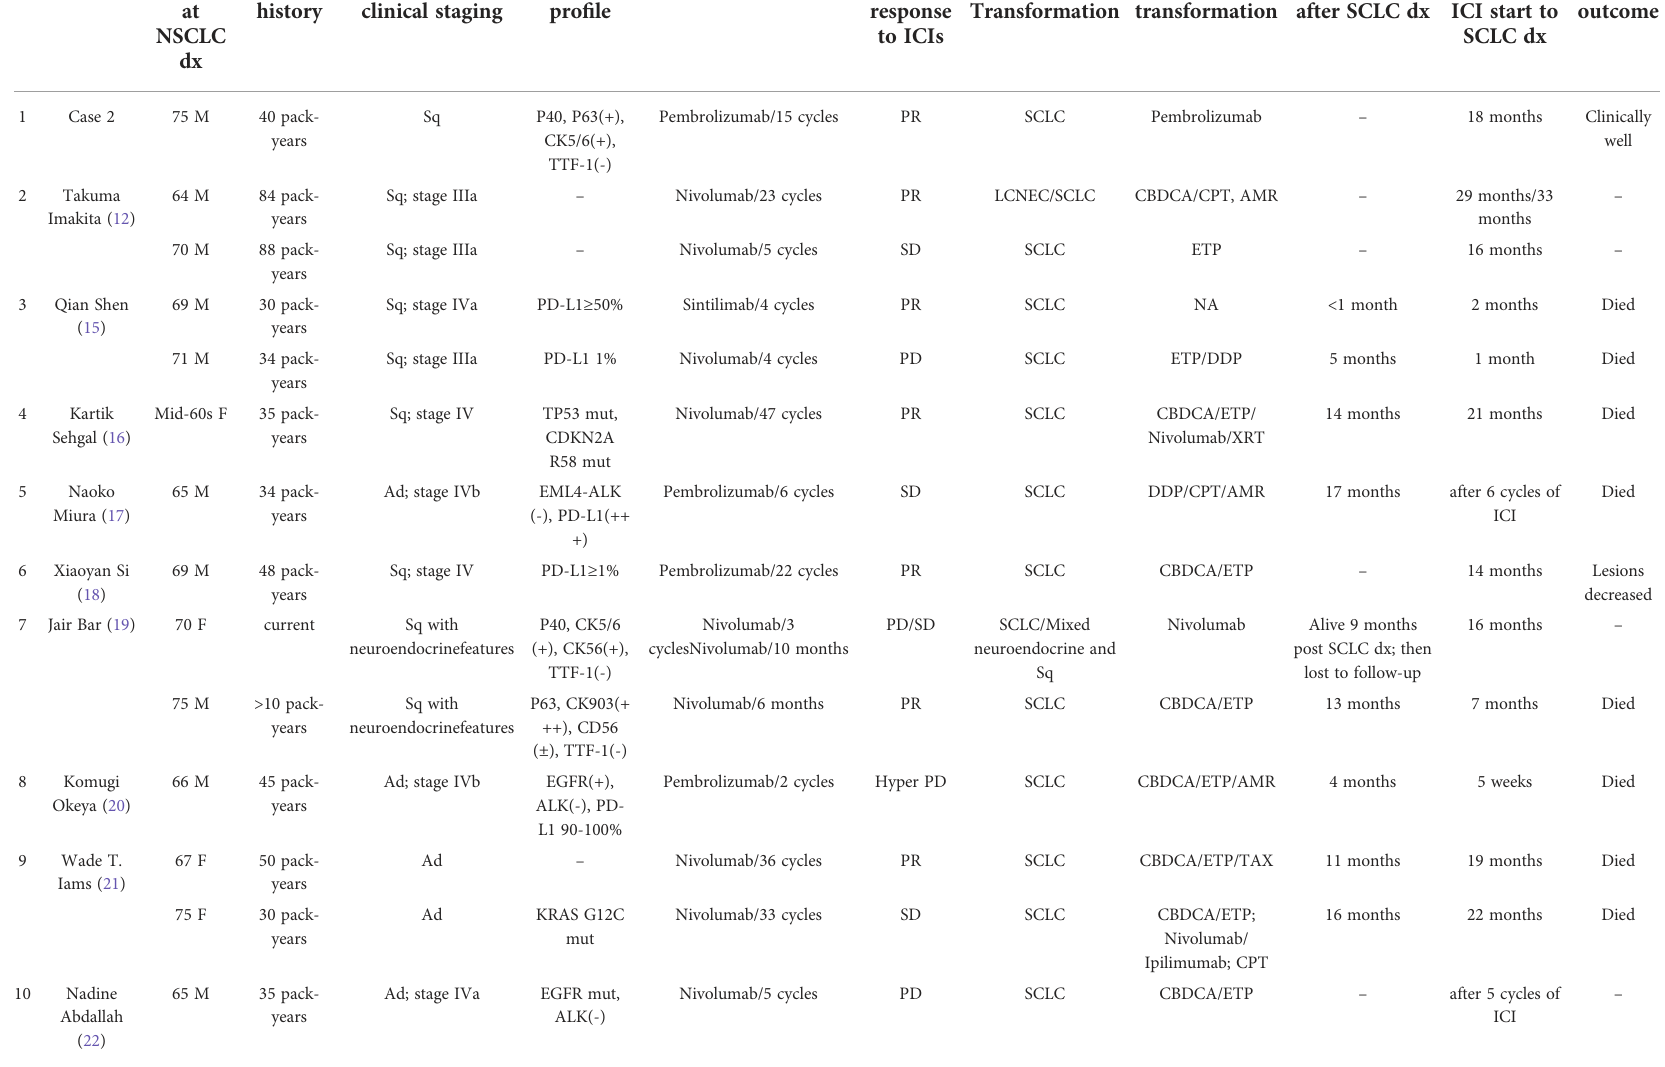
TABLE 1 Case reports of histologic transformation treated with